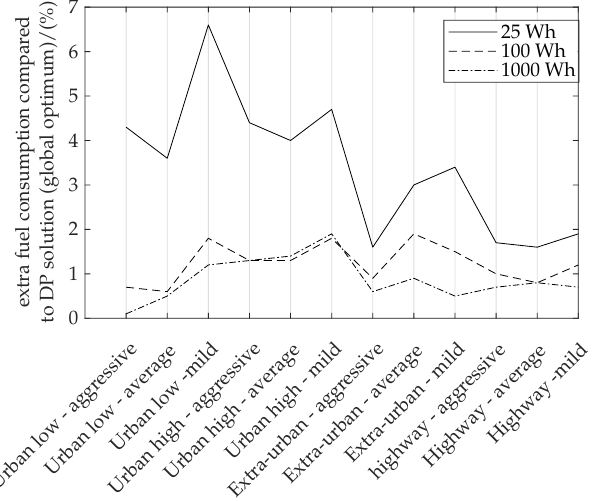
Figure 9. Extra fuel consumption of proposed non-predictive Online ECMS compared to the global optimum (DP solution) regarding fuel